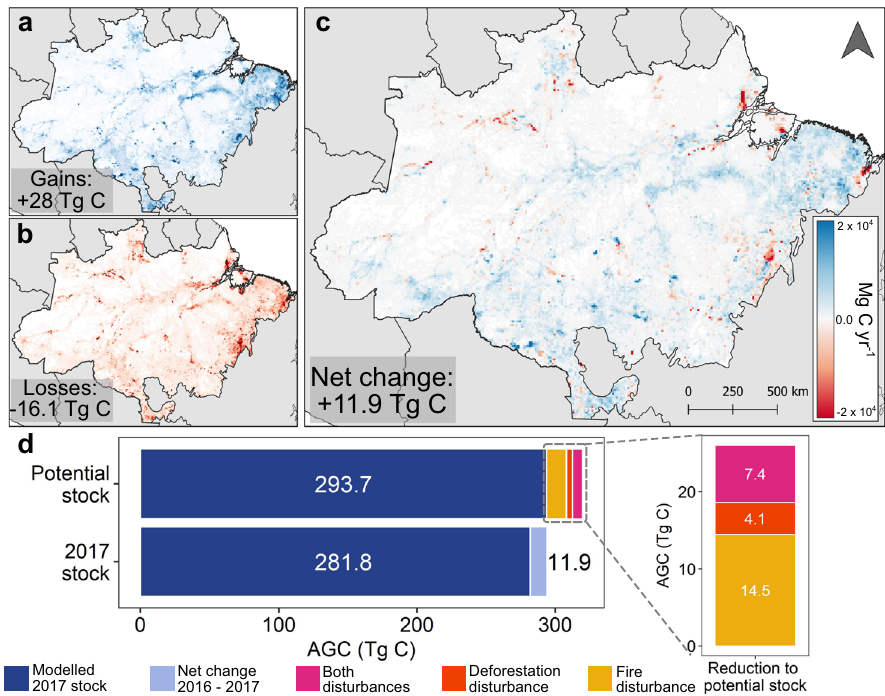
Fig. 4 The net change in secondary forest carbon stock between 2016 and 2017 and the potential 2017 carbon stock without disturbance. This shows a the Aboveground Carbon (AGC) gains from secondary forest growth and recruitment of new secondary forests, and b the losses from reduction in secondary forest area due to deforestation, to provide c a net change in the carbon stock between 2016 and 2017 per 0.1° grid. In Panel d the bottom bar shows the total carbon stock in 2016 (dark blue) with the net gain in carbon stock in 2017 (light blue). Panel d top bar shows the total carbon stock in 2017 (dark blue) and the potential carbon stock that would have been accumulated in secondary forests from their initial establishment (post the start of the study period in 1985) up until 2017 assuming none of the forest experienced any kind of disturbance (burning or repeated deforestation cycles prior to regrowth), using the region-speci fi c regrowth models from non-disturbed secondary forests developed in this study.